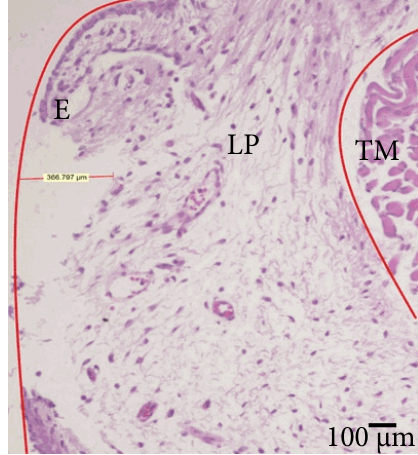
Figure 4 - Histologic confirmation of lesion depth. Microscopic examination of the vocal fold (200× magnification) shows stratified nonsquamous keratinized epithelium with discontinuation. The superficial layer of the lamina propria presents edema, capillary congestion with few lymphocytes and plasmocytes. No exposure of the thyroarytenoid muscle is visible. The vocal ligament is intact. E = epithelium; LP = lamina propria; TM = thyroarytenoid